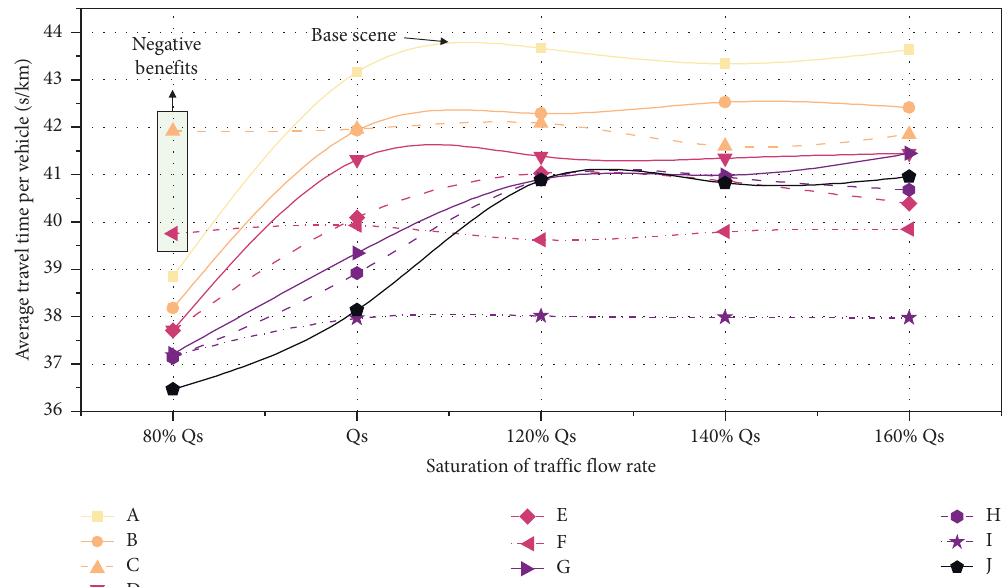
Table 3: Te value of the average travel time per kilometer and its variation from scene A. Scenes